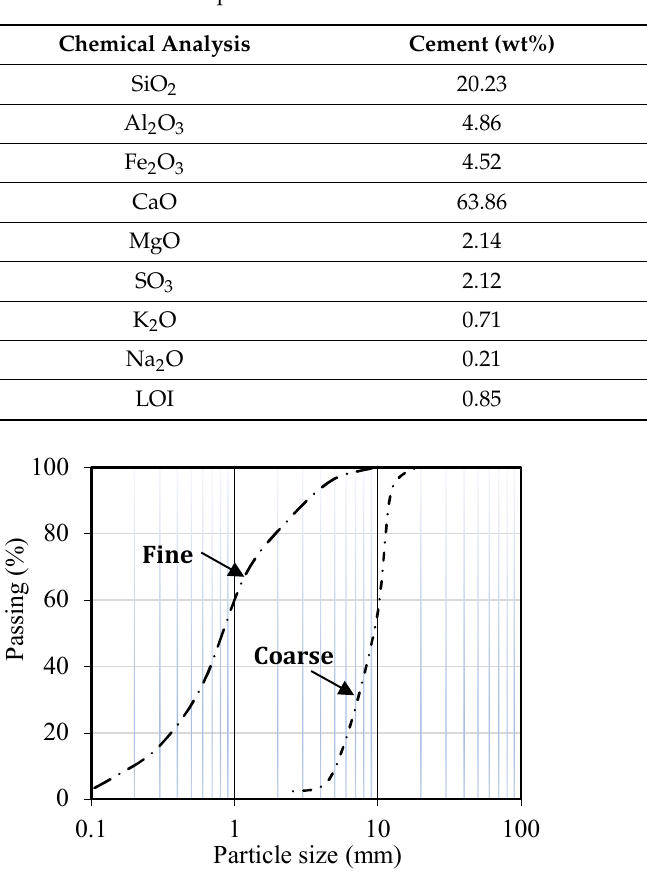
Table 2. Chemical composition of cement and silica fume.